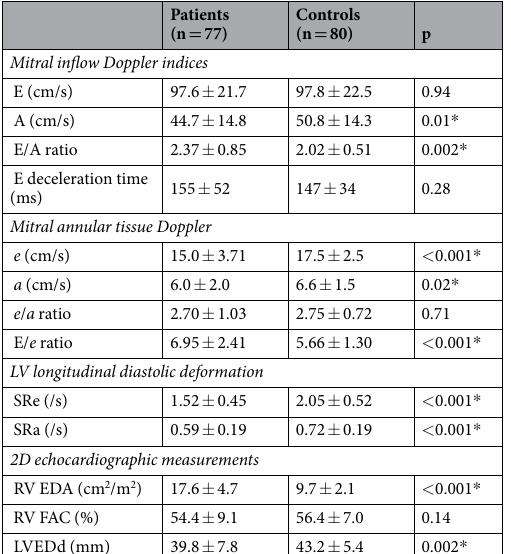
Table 1. Echocardiographic indices in patients and controls. A, transmitral late diastolic inflow velocity; a, late diastolic annular myocardial velocity; E, transmitral early diastolic inflow velocity; e, early diastolic annular myocardial velocity; FAC, fractional area change; LV, left ventricular; LVEDd, left ventricular end-diastolic dimension; RV, right ventricular; SRa, left ventricular late diastolic strain rate; RV EDA, RV end diastolic area; SRe, left ventricular early diastolic strain rate. * Statistically